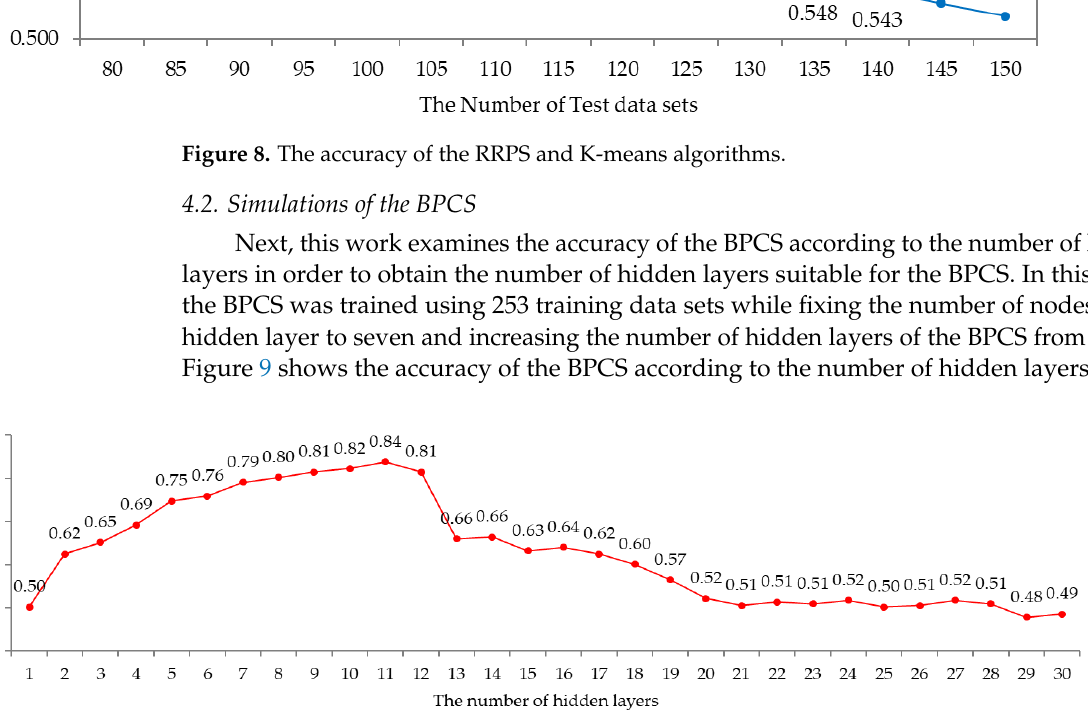
Figure 8. The accuracy of the RRPS and K-means algorithms.